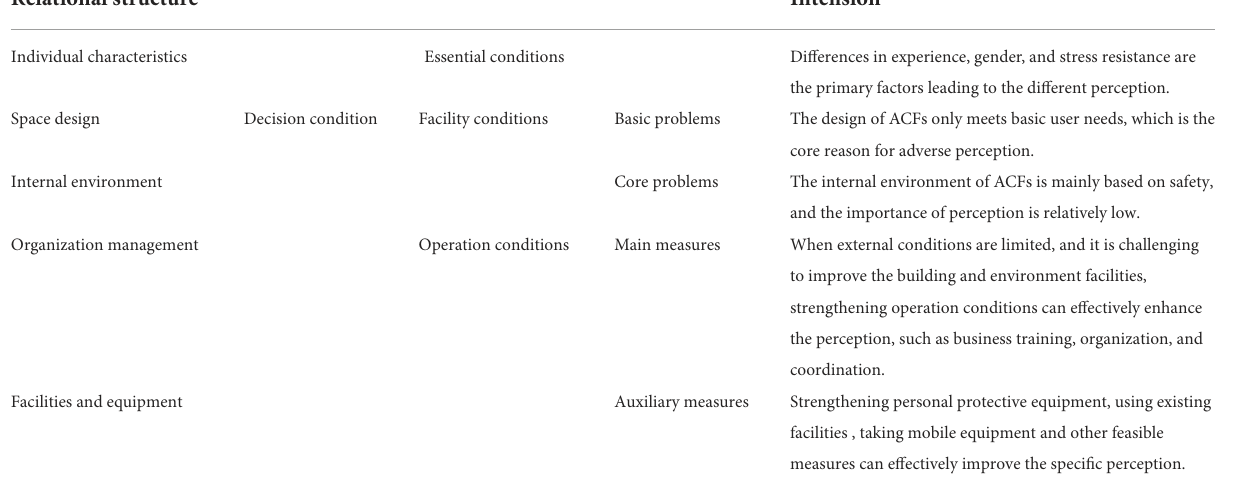
TABLE 4 Relational structure of the main